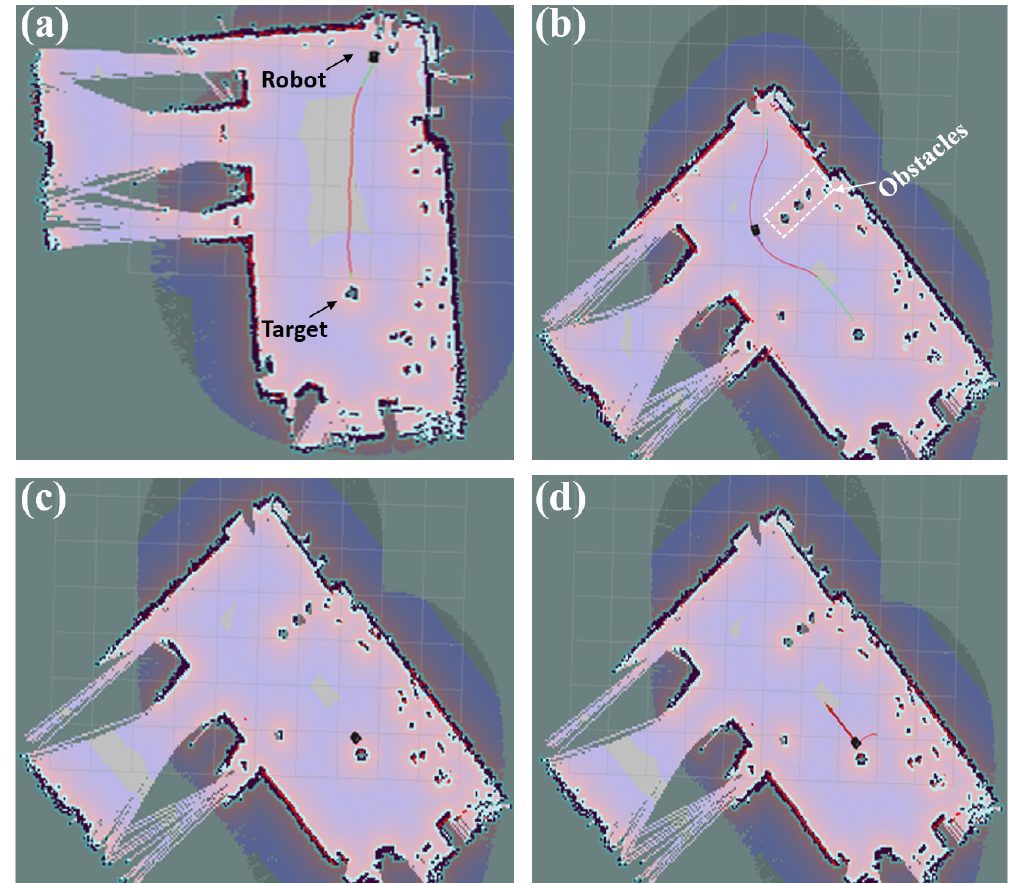
Figure 18. Experimental verification of the robot real-time route re-planning function with the binocular vision system using the X–Y plane projection map. ( a ) A shortest path route calculated on the initial digital map between the robot and target; ( b ) A new path calculated from the new robot location to target once obstacles were identified during its navigation process; ( c ) Robot reaches the target with the obstacles avoided; ( d ) Robot route planning process for returning back to the starting